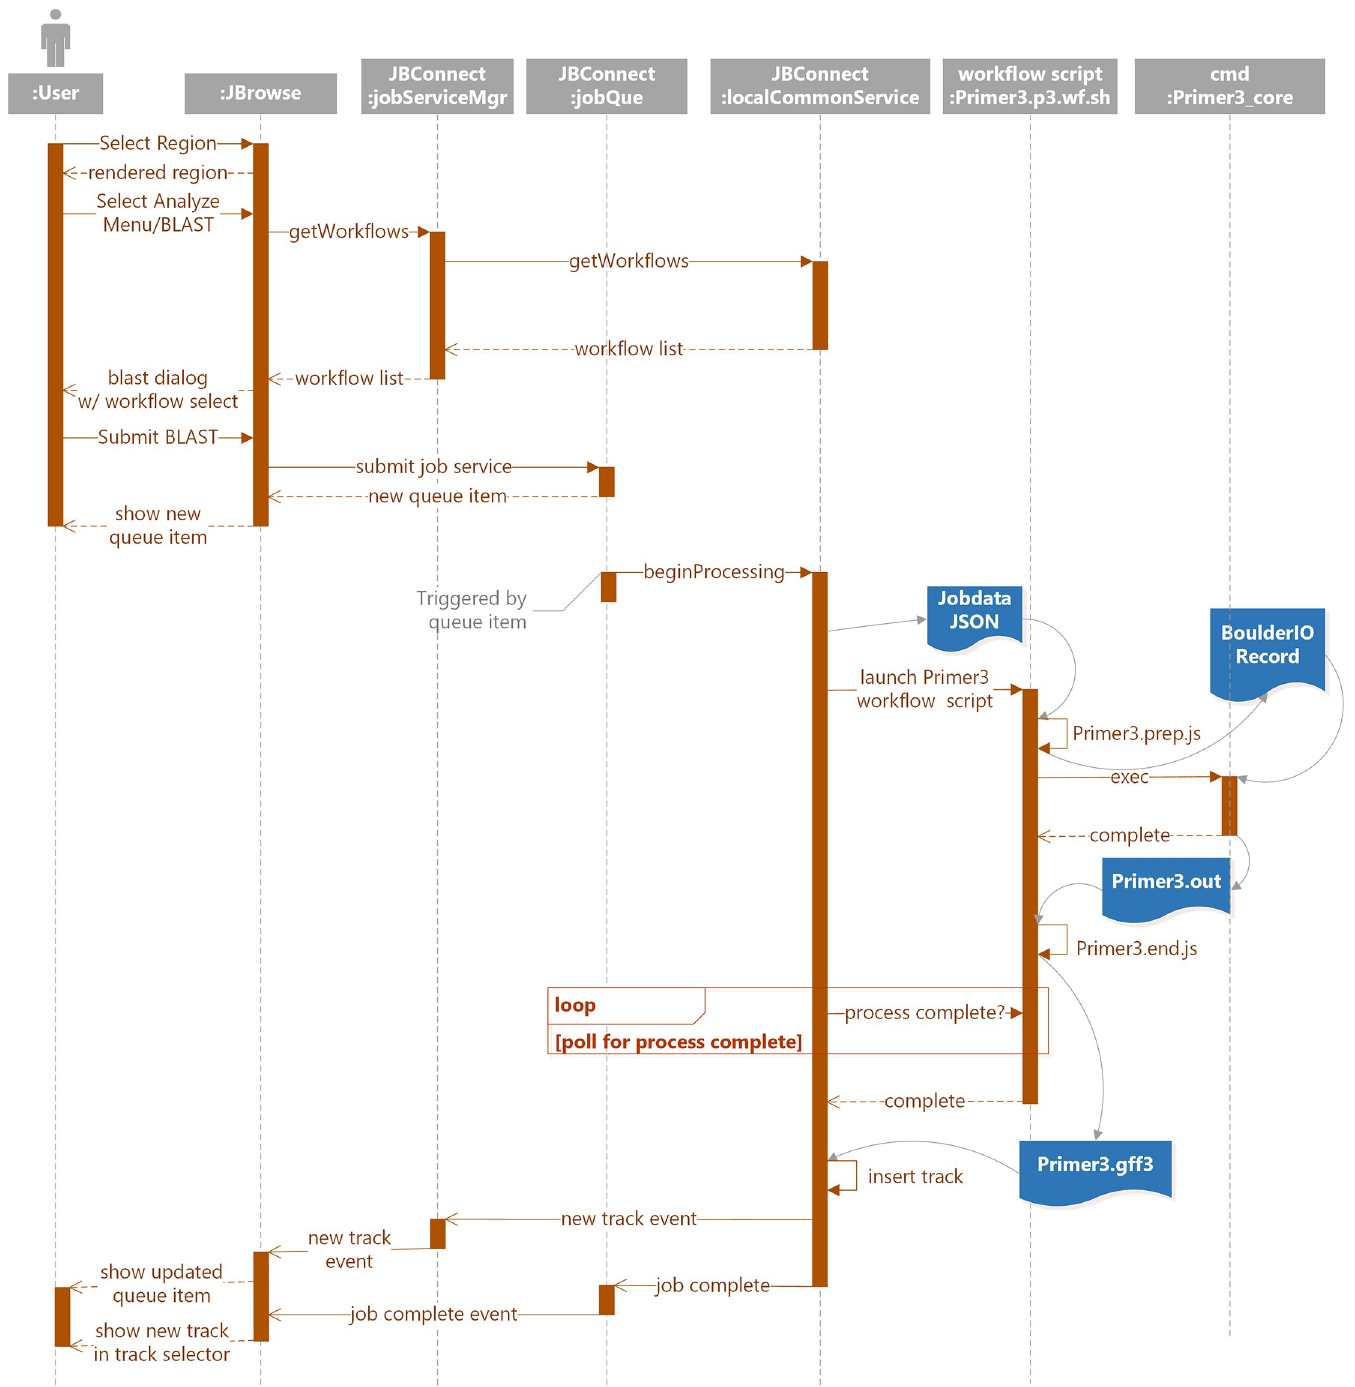
Fig 7. Interactions between components during a Primer3 job involve the user and JBrowse client, the JBConnect server, and a Primer3-specific script that wraps the Primer3 executable itself.